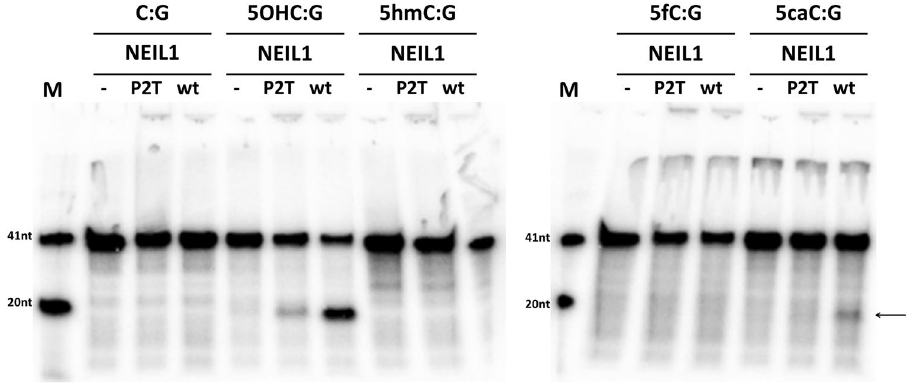
Figure 1. NEIL1 can excise 5caC from DNA: The glycosylase activities of NEIL1 or the control P2T variant were tested using dsDNA substrates (200 nM enzyme, 20 nM dsDNA). The 32 P radiolabelled strand contained the indicated base in position 20, placed opposite a G base in the complementary strand. After the enzymatic reaction (37 °C, 60 min), samples were subjected to alkaline conditions to break DNA strands at AP-sites. DNA was analysed by denaturing gel electrophoresis and visualized by autoradiography. The 5 ′ cleavage product of NEIL1 glycosylase activity on the 5caC containing DNA is marked by an arrow. In this and the following figures, “-” designates the absence of